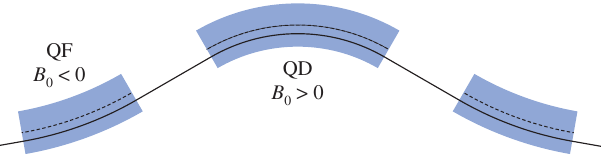
FIG. 28. (Color) Geometry of the triplet lattice. The ‘‘magnet center offset from reference orbit’’ listed in Table VI is positive for both magnets in this diagram.